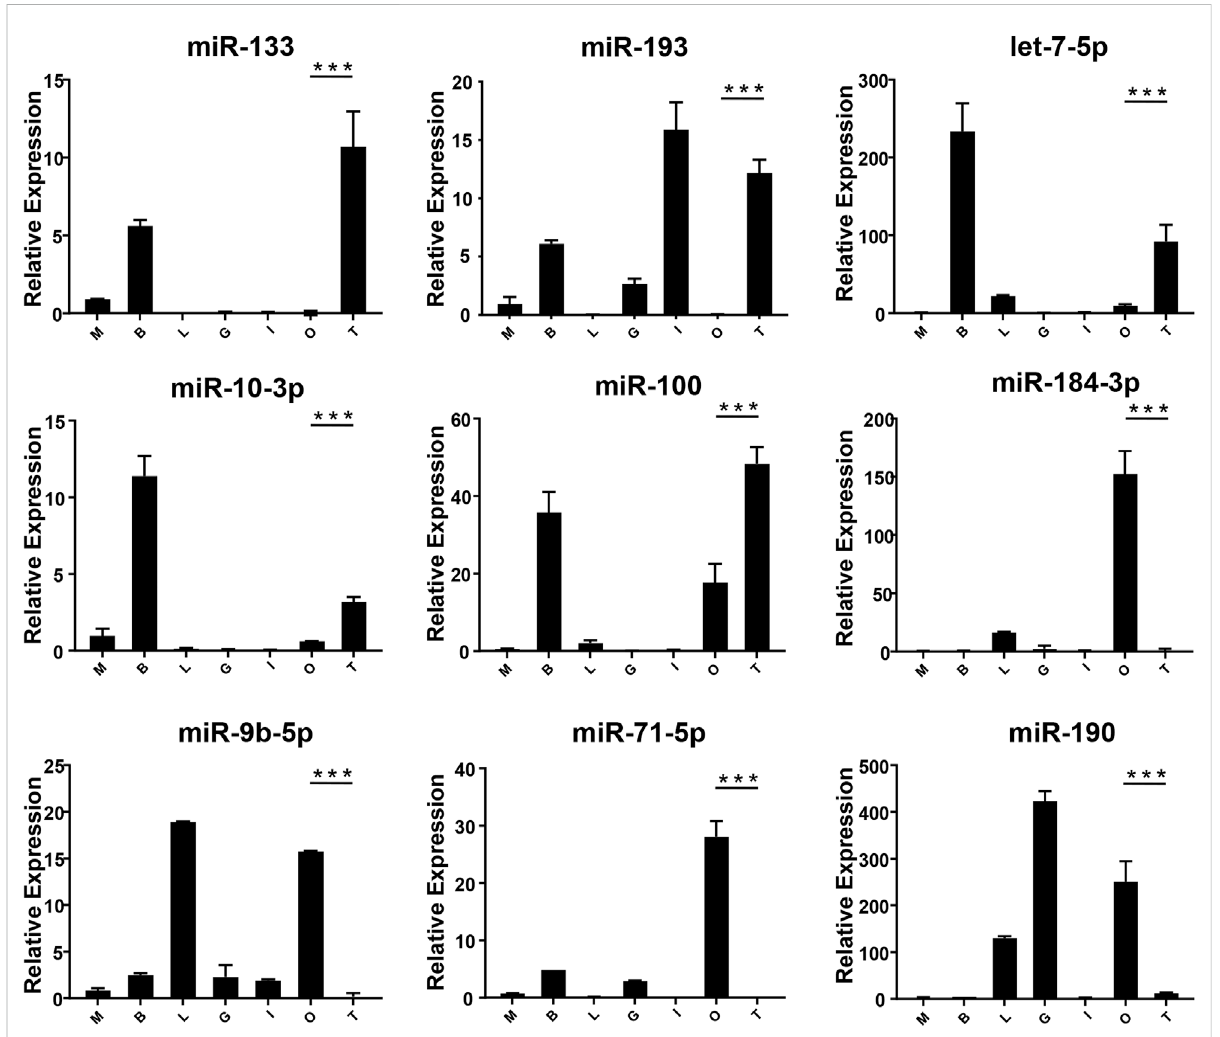
FIGURE 5 The expression of DEMs in the gonad of M. rosenbergii . The endogenous reference gene was U6 , and its expression was determined by comparativeCT( ΔΔ CT )methods.M:muscle;B:brain;L:liver;Ggill;I:intestines;O:ovary;T:testis.*:0.01 < p < 0.05;**:0.001 < p < 0.01;***: p <